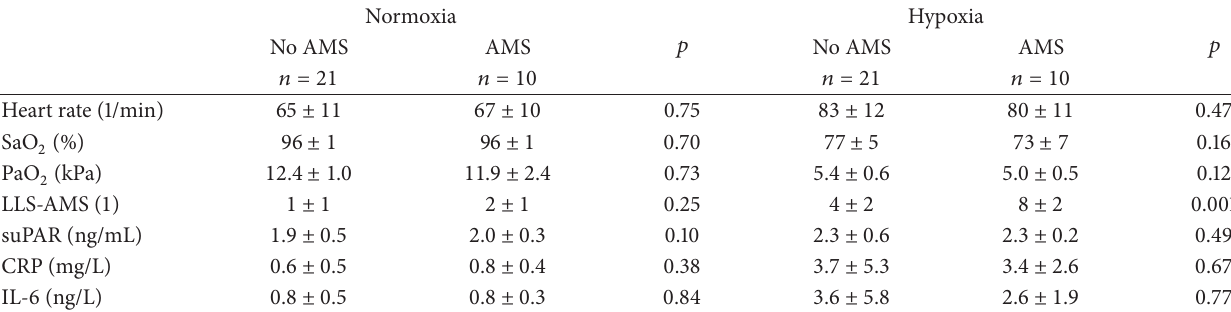
Table 3: Inflammatory markers and physiologic parameters of persons developing AMS versus those not developing AMS during acute hypoxic exposure and retrospectively at sea level (normoxia).